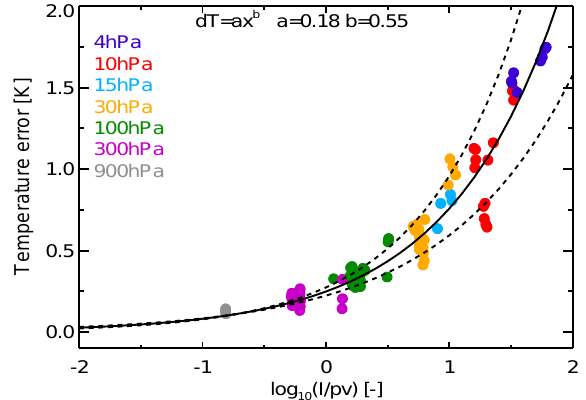
Figure 3. Temperature difference between the illuminated and the Fig. 3. Temperature difference between the illuminated and the shaded RS92 temperature sensors. The direct shaded RS92 temperature sensors. The direct solar irradiance, as solar irradiance, as monitored by an external pyranometer was approximately 800 ( monitored by an external pyranometer, was approximately 800 experiment. The pressure was 100 hPa and the ventilation speed 5 ms − 1 . ( ± 10)Wm − 2 during the experiment. The pressure was 100hPa, and the ventilation speed 5ms − 1 .